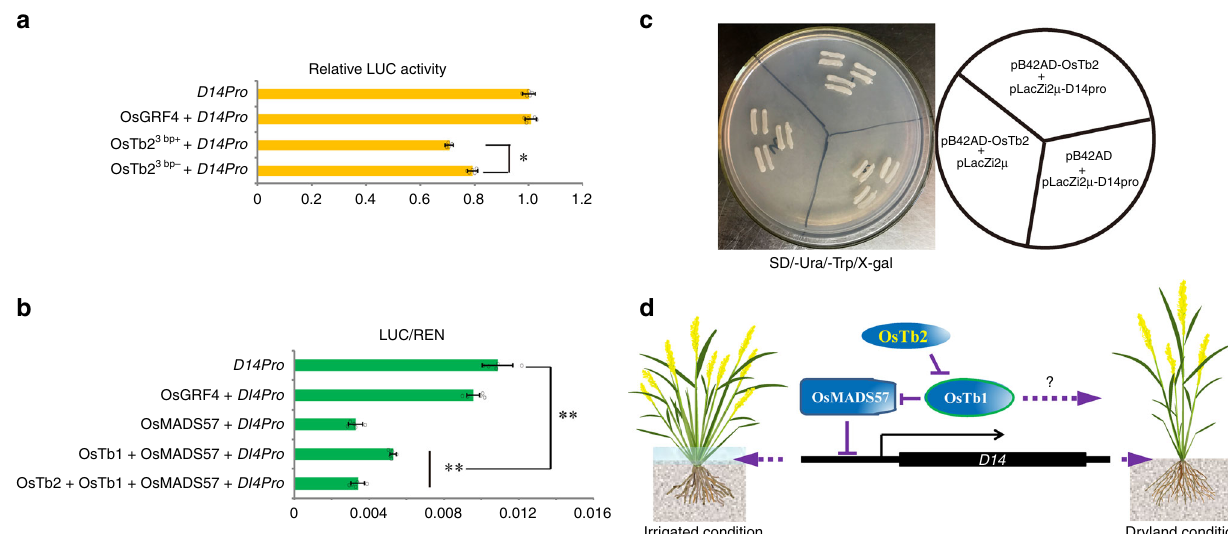
Fig. 4 OsTb2 3bp + negatively regulates D14 via the OsTb1-OsMADS57-D14 pathway. a Effects of OsTb2 3bp + and OsTb2 3bp − on the transcriptional regulation of D14 in rice protoplasts. b Effects of OsTb2 3bp + on the transcriptional regulation of D14 via the OsTb1-OsMADS57-D14 pathway in Nicotiana benthamiana . OsGRF4 is used as a negative control for detecting the effects of OsTb2 on D14pro::LUC activity. Each relative luciferase activity of D14pro::LUC value in a and b represents the mean ± s.d. (n = 10 biologically independent samples). Student ’ s t -test analysis indicated a signi fi cant difference (* P < 0.05, ** P < 0.01). c In the yeast one-hybrid assay, OsTb2 fusion proteins fail to activate D14pro :: LacZ reporter gene expression in yeast. The right diagrammatic drawing indicates the yeast strains transformed with related plasmids. d A schematic model depicts that OsTb2 interacts with OsTb1 to regulate the expression of D14 . OsMADS57 directly represses the expression of D14 ; OsTb2 interacts with OsTb1 to alleviate OsTb1 ’ s inhibition on OsMADS57, which consequently reduces the expression of D14 and increases